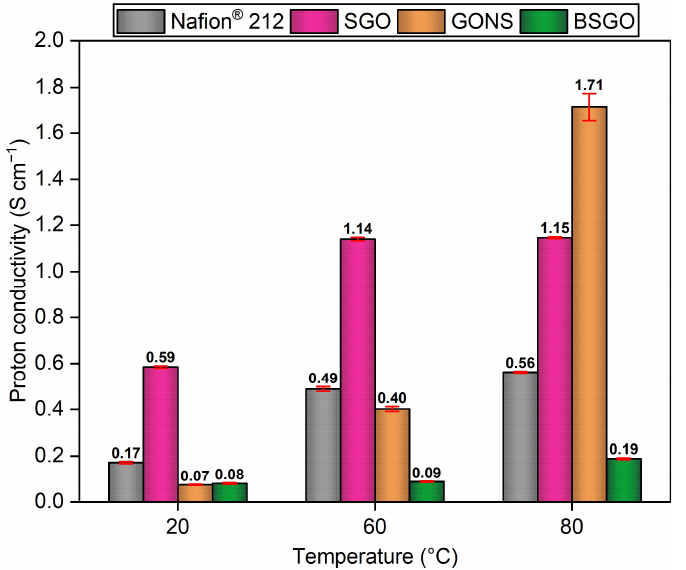
Figure 6. Proton conductivity of the proposed GO-based membranes compared with Nafion ® 212 at 20, 60, and 80 °C.